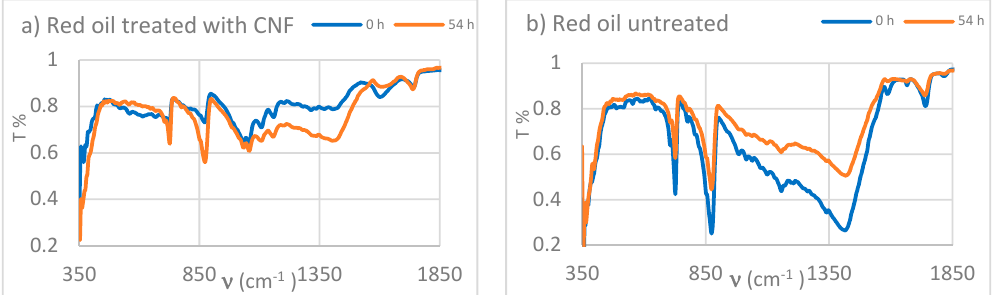
Figure 1. FT-IR spectrum for red oil before (0 h) and after exposure to direct sunlight (54 h); ( a ) treated with cellulose nanofiber (CNF); ( b )